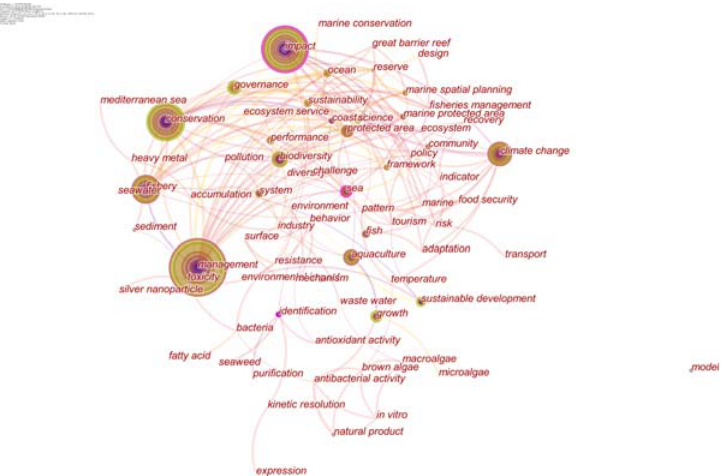
Figure 2. The keywords